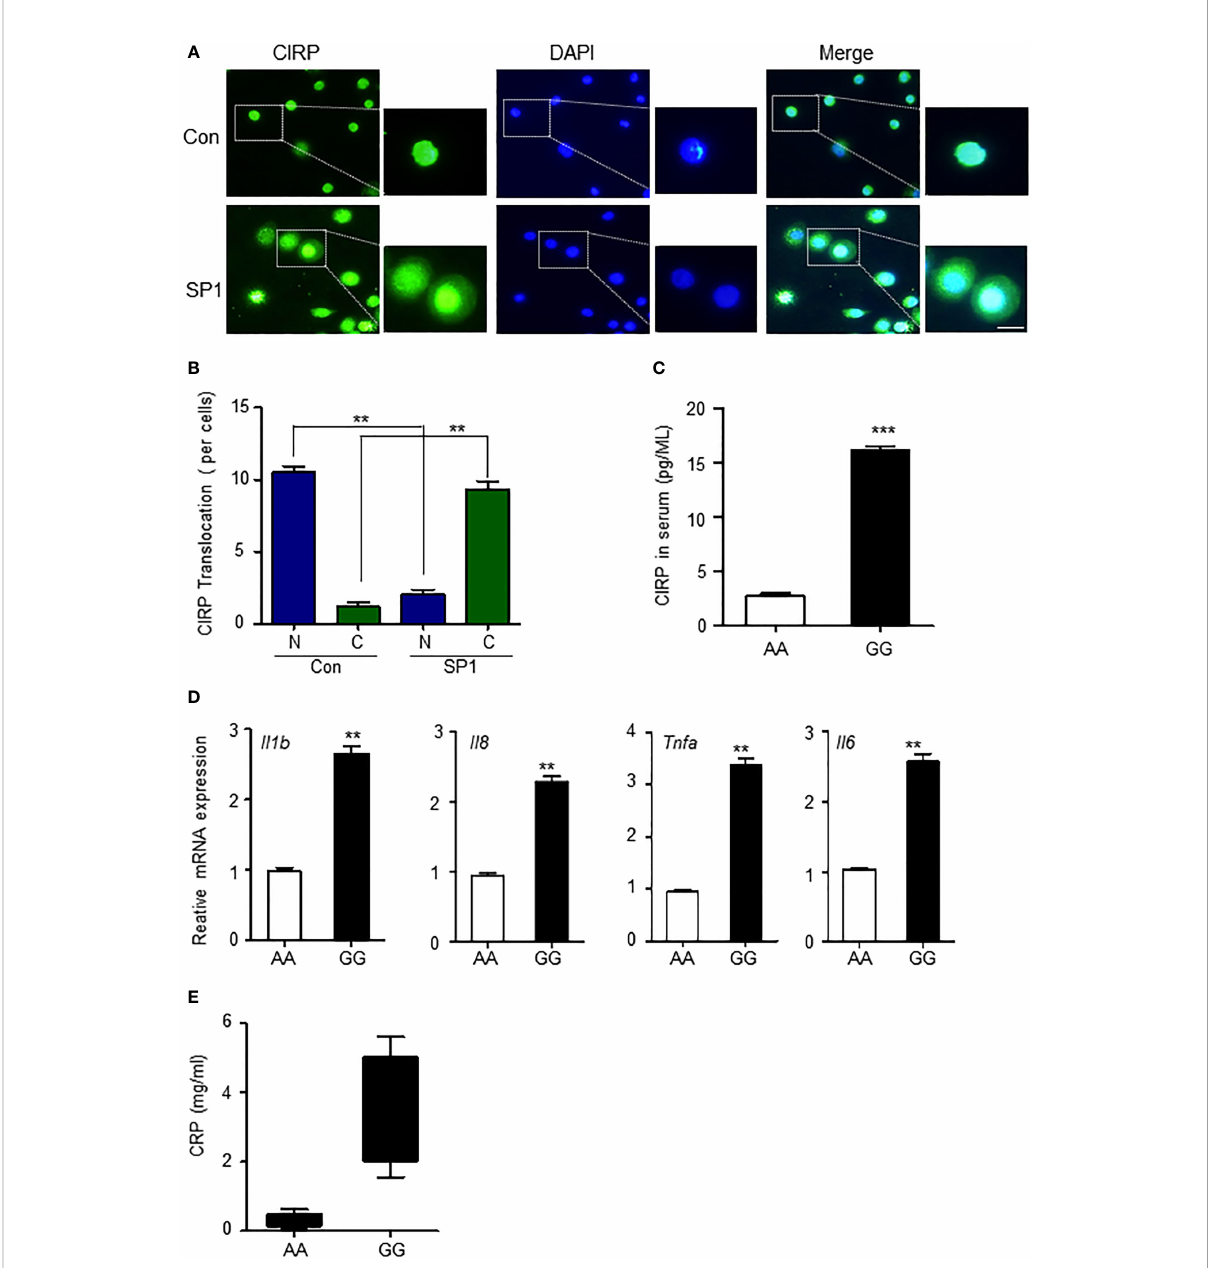
FIGURE 4 CIRP leads to increased in fl ammatory process in the PBMCs by rs11170510 and rs58123204. (A) THP-1 cells were transfected with the Sp1 plasmid for 24 (h) Immuno fl uorescence microscopy analysis of CIRP. Merged signals of CIRP (Alexa Fluor 488-conjugated goat anti-rabbit IgG, green) and DAPI (nuclei, blue). scale bar: 10 um. (B) Quanti fi cation of translocation in then nucleus to cytosol foci per cell. (C) CIRP levels were measured in serum with major allele or minor allele of the rs11170510 and rs58123204 (n = 10, major homo AA; n = 10, minor homo GG) using CIRP ELISA kit. (D) PBMCs were analyzed using the quantitative PCR of Tnf- a , Il6, Il-1 b , and Il8 mRNA levels. (E) C-reactive protein levels were measured in serum containing major A allele or minor G allele of rs11170510 and rs58123204 (n = 10, major homo AA; n = 10, minor homo GG). Experiments were repeated at least three times. Graphs are indicative of the mean ± SD. **p < 0.01 and ***p < 0.001 (two-tailed unpaired Mann –